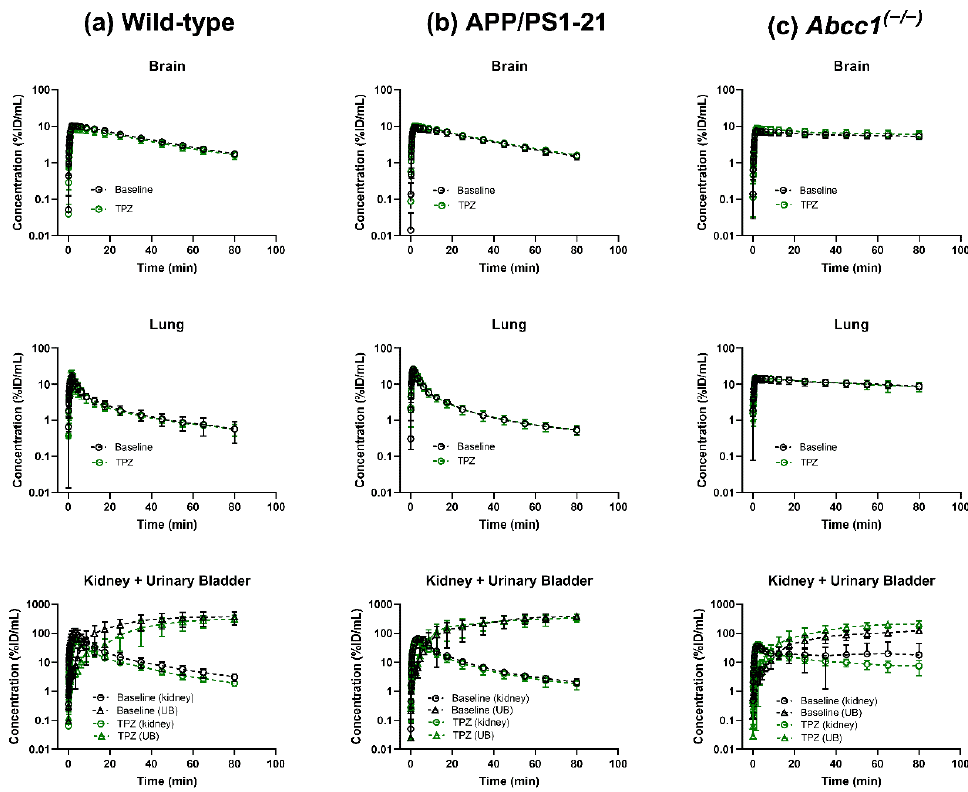
Figure 2. Time-activity curves (mean ± SD) measured after i.v. injection of [ 11 C]BMP in the brain, the right lung, and the left kidney and urinary bladder (UB) of wild-type mice ( a ), APP/PS1-21 mice ( b ) and Abcc1 ( − / − ) mice ( c ) at baseline and following 5-day oral treatment with thiethylperazine (TPZ, 15 mg/kg, once daily). Table 2. Elimination rate constants ( k elim , h − 1 ) in the brain, the right lung and the left kidney of the three mouse strains before and after treatment with